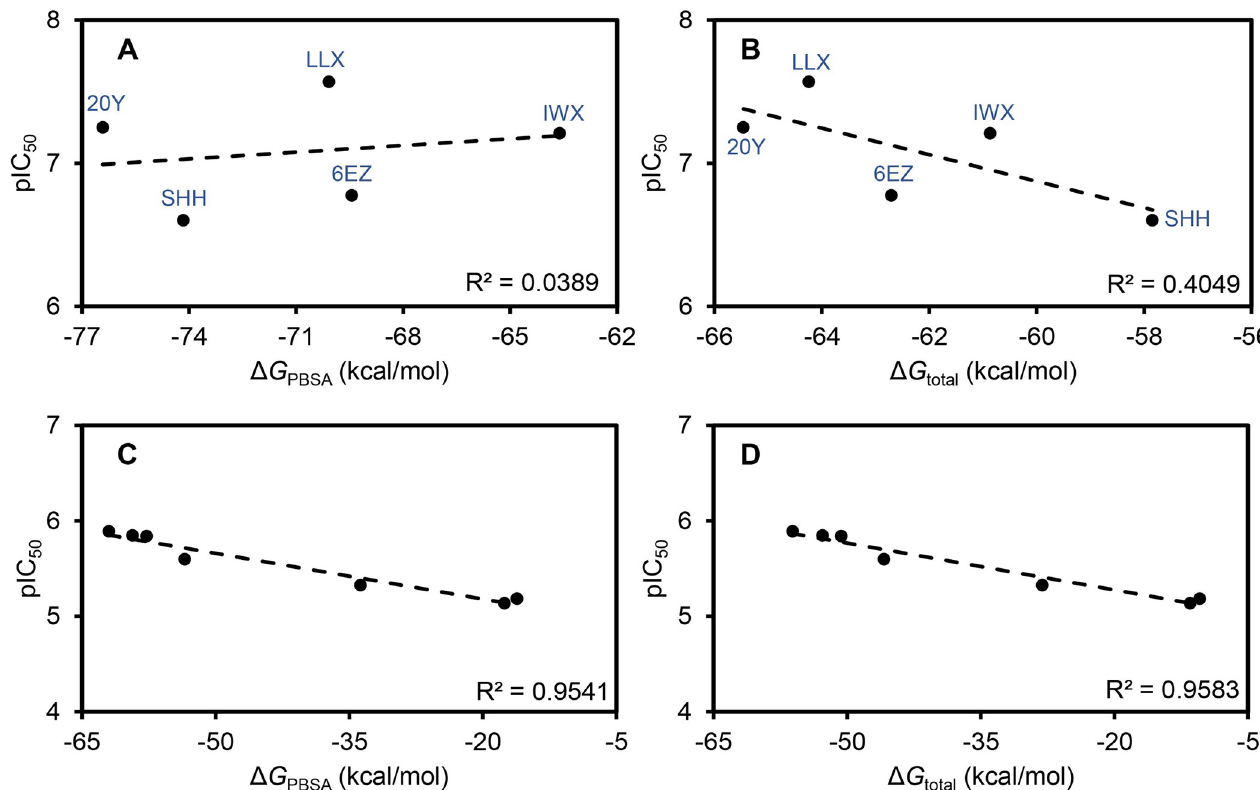
Fig 8. Correlation plots between experimental pIC 50 values of HDAC2 inhibitors and the binding free energies of their complexes with HDAC2 calculated from MM-PBSA and additional entropic term estimations. Actual pIC 50 potencies of known HDAC2 inhibitor ligands (A and B) or a set of carbamide derivatives (C and D) are plotted against the binding free energies of their complexes calculated from MM/PBSA alone ( Δ G PBSA ) (A and C) or calculated as total binding free energies by the addition of entropic term estimations ( Δ G total ) (B and D).